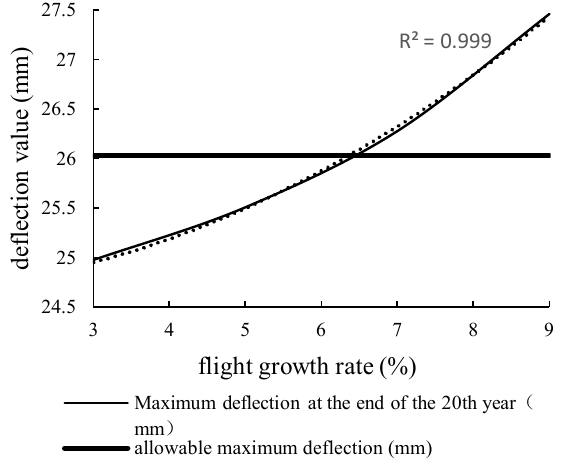
Figure 11. The maximum deflection of the taxiway bridge mid-span under different flight growth rates.